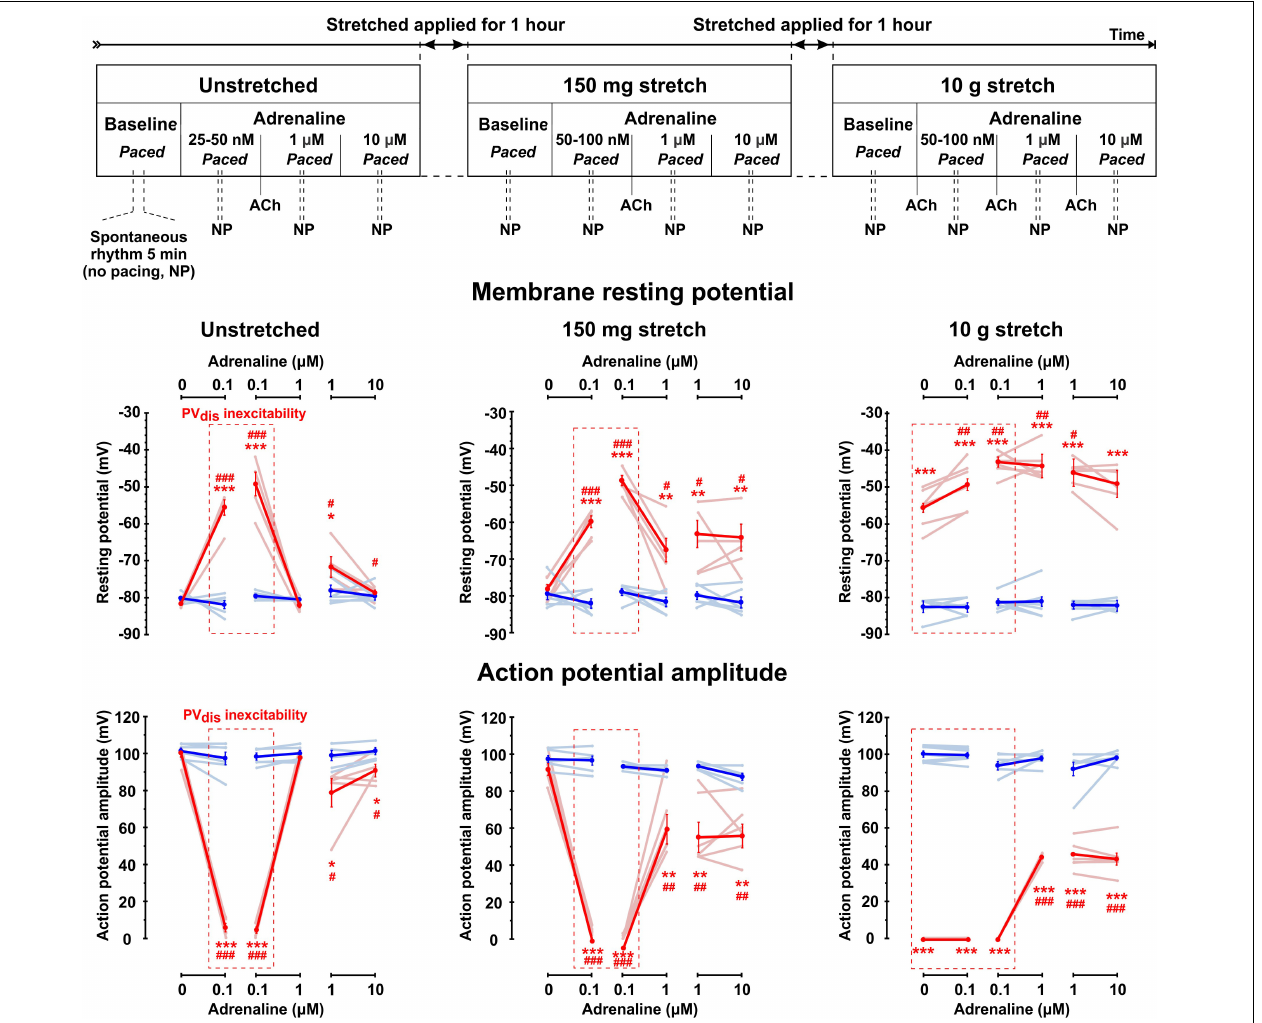
FIGURE 1 | Complex interactions between sympathetic tone and mechanical stretch in rat pulmonary vein (PV) myocardium. Top: Experimental protocol for testing different levels of sympathetic stimulation in unstretched and stretched PV preparations. Physiological status of PV dis inexcitability induced be either low concentrations of adrenaline (25–100 nmol/L), or pathological stretch (10.5 g) was tested by a brief application of acetylcholine (ACh), which was administered to hyperpolarize the RP and recover PV dis excitability and then washed out to continue experimental protocol. All measurements were performed during constant left atrial pacing, except brief (5–10 min) periods when pacing was stopped (no pacing, NP), and spontaneous rhythm was recorded if present. Below, changes in the resting membrane potential (middle panels) and action potential amplitude (low panels) are shown for distal (red traces) and ostium (blue traces) PV regions at baseline (no adrenaline applied) and under low (25–100 nmol/L) and high (1–10 µ mol/L) concentrations of adrenaline measured in unstretched and stretched (150 mg and 10 g) preparations. Changes are shown for individual rats (light blue and light red lines) as well as mean ± SEM (solid lines). Red dashed box indicates the presence of PV dis inexcitability. N = 6–7 rats. * P < 0.05, ** P < 0.01, *** P < 0.001 for PV dis vs. PV ost ; # P < 0.05, ## P < 0.01, ### P < 0.001 within the same group vs. baseline by repeated measurements two-way ANOVA with Bonferroni